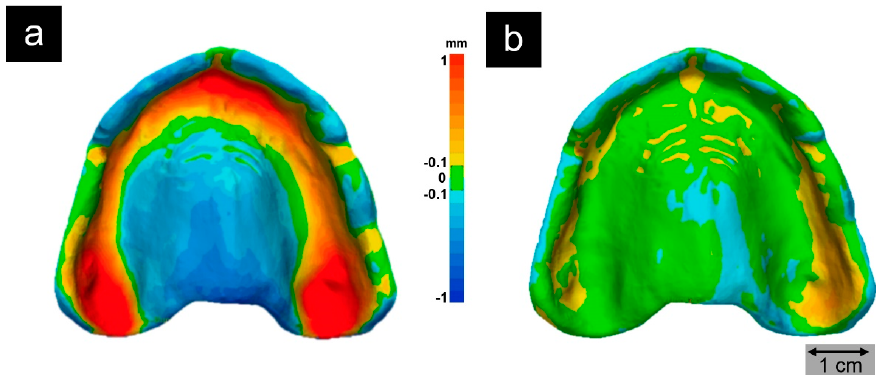
Figure 6. Target-actual comparison of the intaglio surface of a FFF printed denture base made of medical-grade PP applying standard PP printing conditions ( a ) and a warpage-optimized PP with reduced crystallinity after 3D printing process optimization in terms of pre-deformed, warpage-compensating CAD files and temperature management ( b ). Printed denture bases were digitized (VL 500, Keyence, Osaka, Japan) and compared to the original STL file with an inspection software program (Geomagic Control X, 3D Systems, Rock Hill, SC, USA). The data of the intaglio surfaces was superimposed with the data of the original by using a local best-fit algorithm according to Gauss. Subsequently, a 3D surface comparison was carried out and the discrepancies were illustrated using a color map with a tolerance of ±100 µm (green).